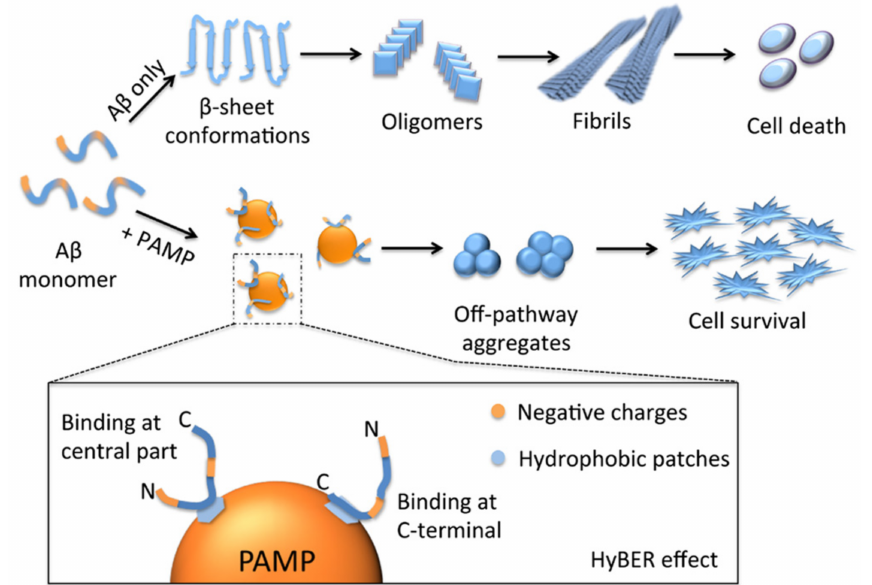
Figure 8. Schematic representation of the inhibition of amyloid aggregation by PAMP caused by the HyBER effect. The top panel represents the on-pathway fibrillation of A β 42, and the bottom panel represents the off-pathway aggregation of A β 42 modulated by the PAMP of a proper DS value (e.g., PAMP3 with a DS of 30.5%) by the HyBER effect (depicted in the amplified drawing of A β 42 − PAMP interactions). Reprinted with permission from ref. [159]. Copyright 2018, American Chemical